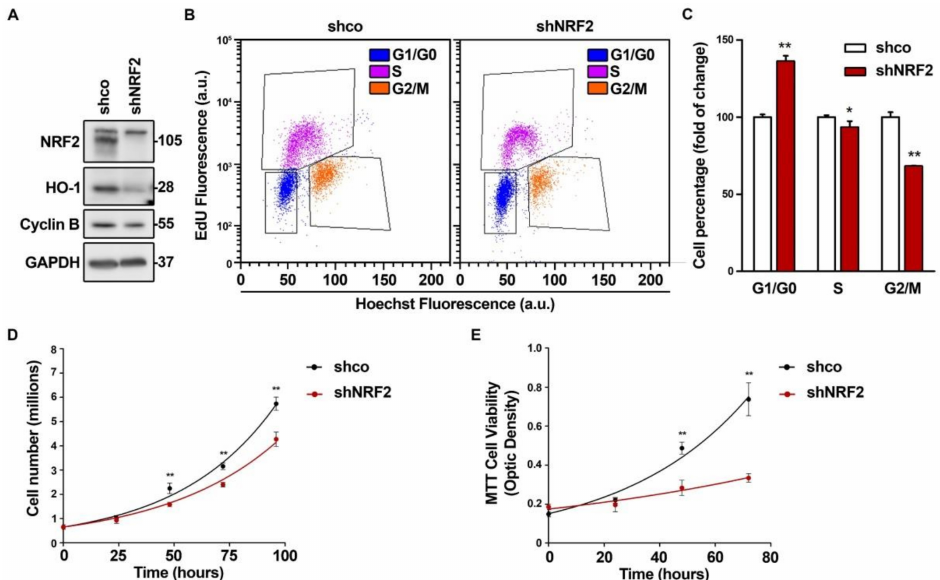
Figure 1. NRF2 deficiency alters cell cycle distribution and proliferation rate. U–373 MG cells were transduced with lentiviral vectors containing control (shco) or shNRF2–1 (shNRF2). ( A ) Representa- tive immunoblot analysis of NRF2, HO–1, Cyclin B, and GAPDH as a loading control; ( B ) Changes in cell cycle distribution between G1, S, and G2/M phases were determined by combined EdU and Hoechst staining (a.u., arbitrary units of fluorescence emission). A representative sample of 10,000 cells is shown for each condition; ( C ) Flow cytometry analysis of changes in cell cycle distribution for G1, S, and G2/M phases in EdU/Hoechst–stained cells. Data are presented as mean ± S.D. ** p ≤ 0.01; * p ≤ 0.05 vs. shco according to a Student’s t -test ( n = 3); ( D ) Proliferation rates of shco and shNRF2 cells were determined by trypan blue staining. The curve was fitted according to an exponential growth model with the least square fit. Data are presented as mean ± S.D. ** p ≤ 0.01 vs. shco according to a two–way ANOVA test ( n = 3); ( E ) Proliferation rate in shNRF2 cells based on the MTT metabolic assay. The curve was fitted according to an exponential growth model with the least square fit. Data are presented as mean ± S.D. ** p ≤ 0.01 vs. shco according to a two–way ANOVA test ( n = 4).